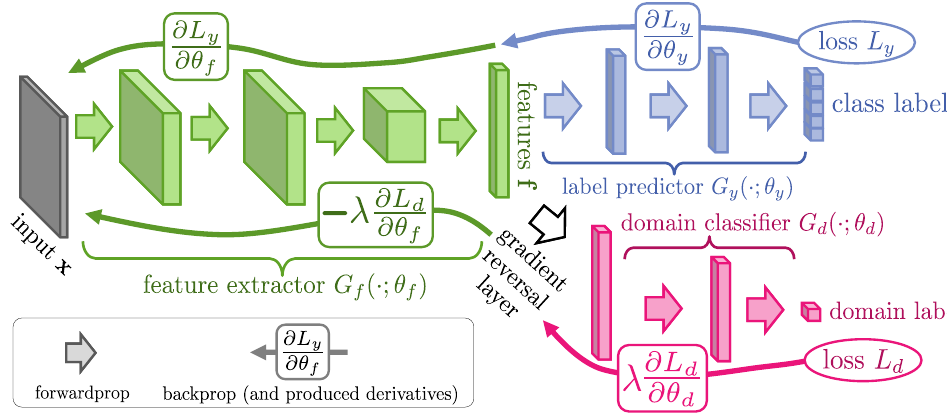
Figure 7. Architecture of the DANN first proposed in Figure 1: The proposed architecture includes a deep feature extractor (green) and a deep label predictor (blue), which together form a standard feed-forward architecture.